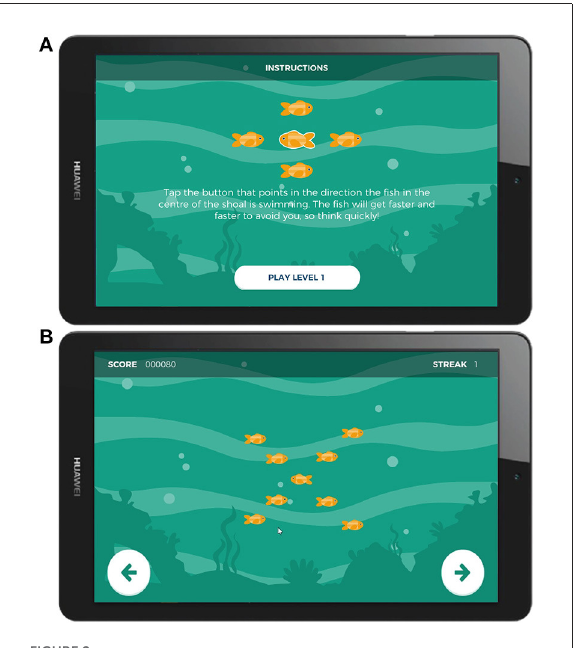
FIGURE2 Screenshots of Gamified Adaptive Flanker task. (A) Instruction screen, (B) Screenshots of the stimulus